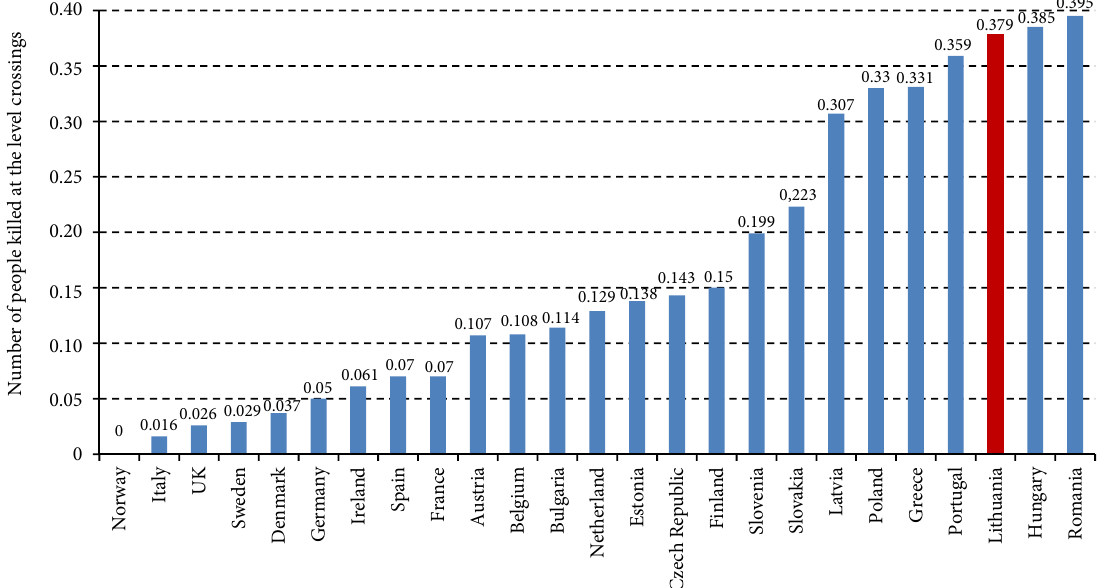
Fig. 1. A number of people killed at the crossings of EU and Norway per train km (a criterion of a number of people killed at the crossings per the distance travelled by trains is the ratio between a number of people killed and the distance travelled by trains per year (in million km) (data from ERADIS)